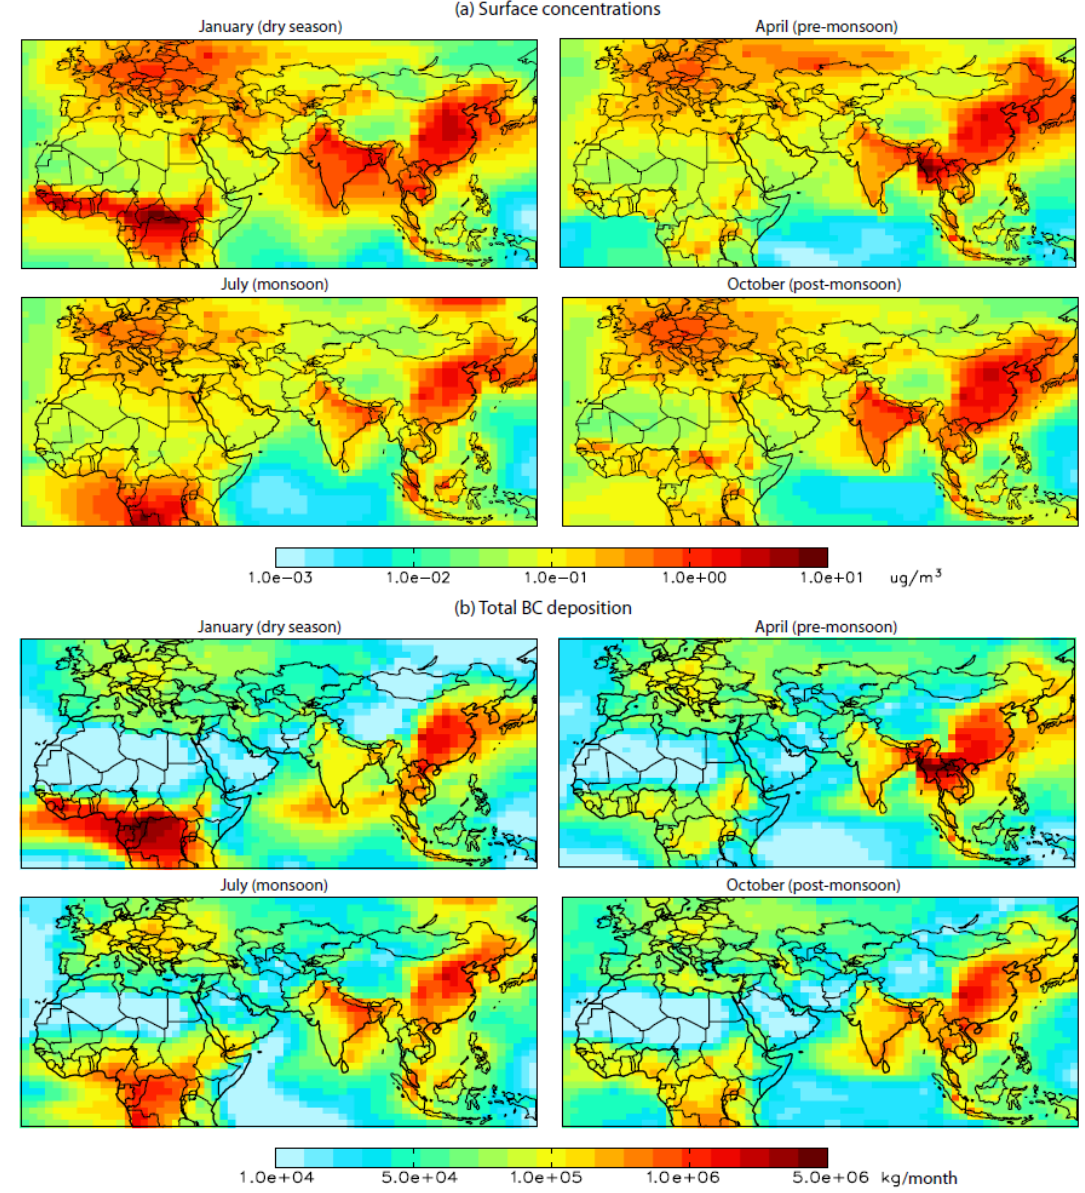
Figure 1. Location of the five glacier sites in the Himalayas and the Tibetan Plateau that we use as receptors in this study. Annual mean surface pressure from GEOS-Chem is overlaid. We compare measured concentrations of BC in snow at these sites with concentrations simulated by GEOS-Chem.